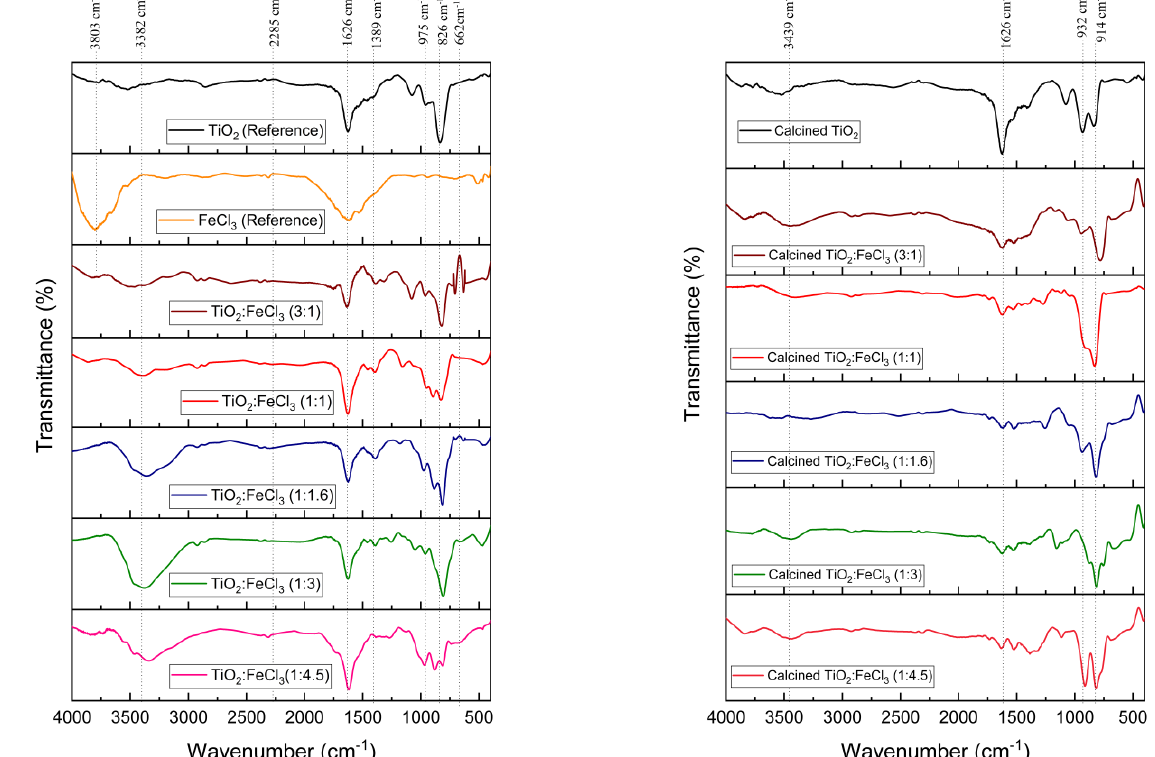
Figure 1. FTIR spectra for the TiO 2 (reference), FeCl 3 (reference), and the samples synthesized before calcination ( left ) and after calcination ( right ).